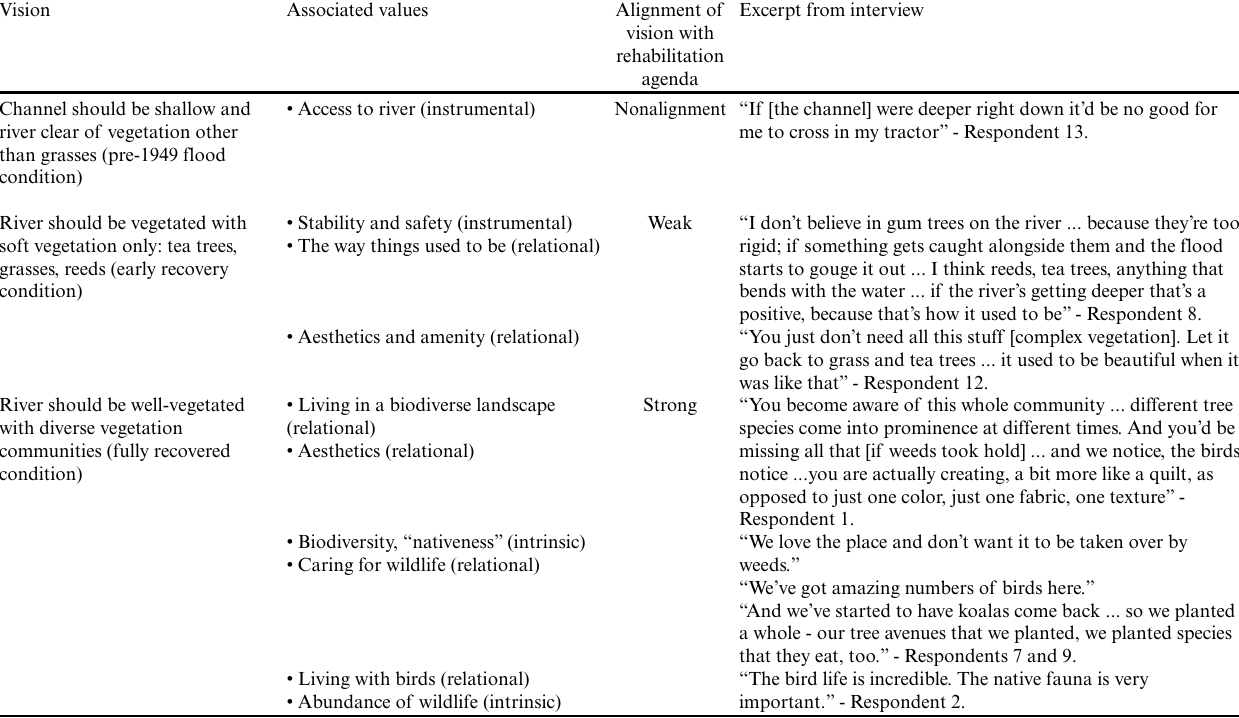
Table 3 . Motivating visions for the river. Vision Associated values Alignment of